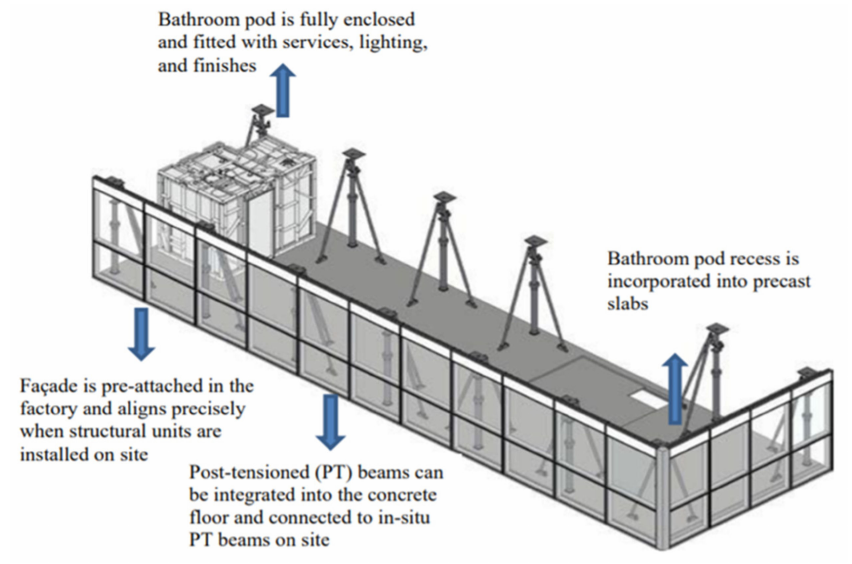
Figure 2. Hickory Building Systems (Source: